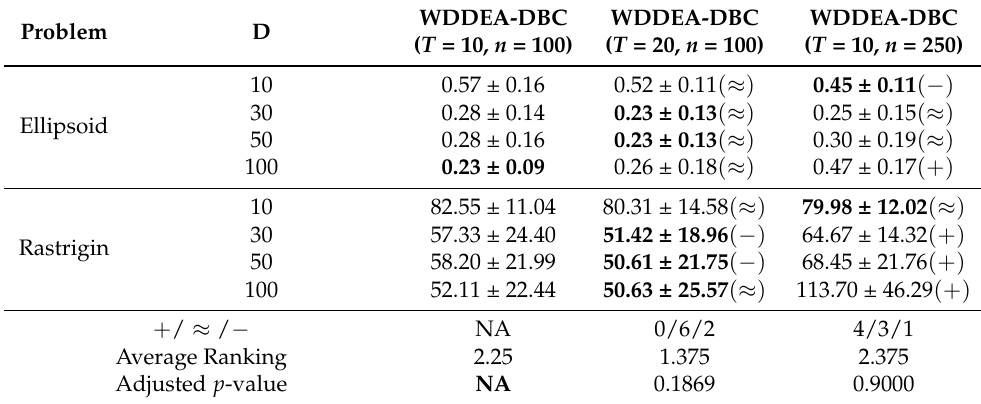
Table 3. The comparisons on optimization results between variants of the proposed algorithm with different settings (the best results and the lowest p -values are shown in